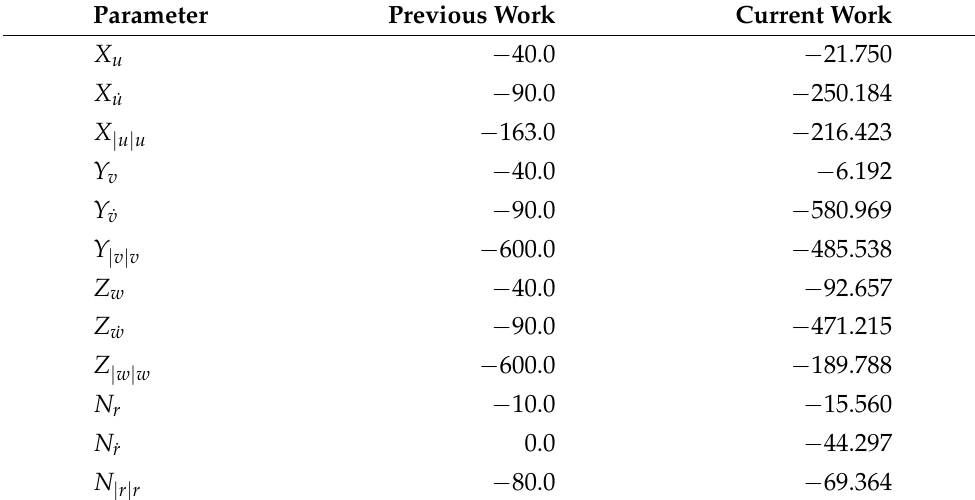
Table 2. Comparison of the AUV dynamic coefficients between previous work and the parameter estimation used in the current